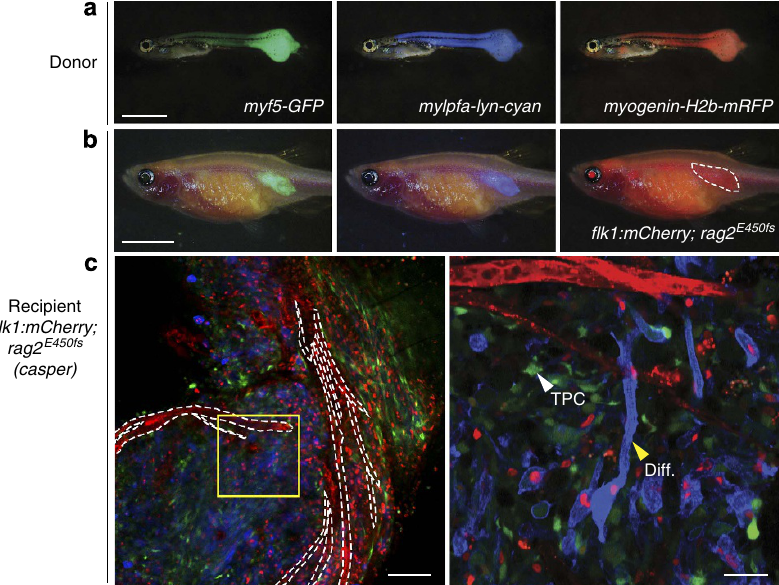
Figure 3 | Resolving tumour cell heterogeneity in ERMS at single-cell resolution following engraftment into flk1:mCherry; rag2 E450fs (casper) zebrafish. ( a ) Epi-fluorescent images of primary ERMS in a 32-day-old myf5:GFP; myogenin-H2b:mRFP; mylpfa:lyn-cyan triple transgenic zebrafish. ( b ) Epi-fluorescent images of flk1:mCherry; rag2 E450fs (casper)- recipient fish engrafted intra-muscularly with fluorescently labelled ERMS at 28 d.p.t. ( n ¼ 4 animals). ( c ) Confocal image with mCherry-labelled vasculature outlined by white dashed lines (left, (cid:3) 100 magnification). Higher magnification of boxed region (right, (cid:3) 400 magnification). Myosin-expressing, differentiated cells (Diff.) and less frequent myf5-GFP þ tumour-propagating cell (TPC) denoted by arrowheads. Scale bar equals 2mm in a , 5mm in b , 100 m m ( c , left panel) and 25 m m ( c , right